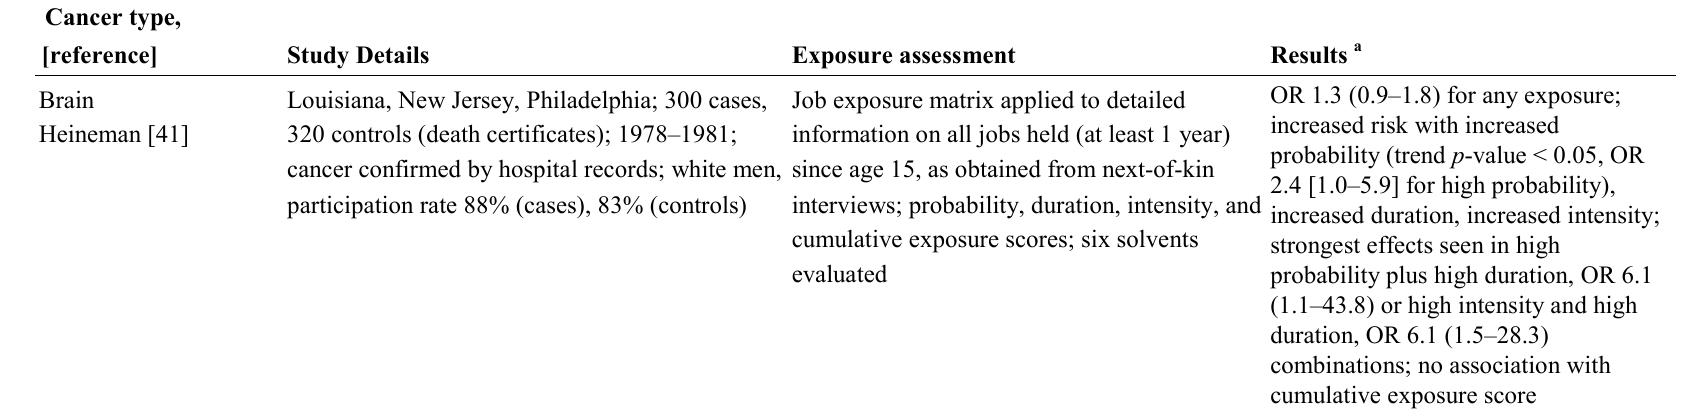
Table 3. Summary of case-control studies of cancer risk and dichloromethane